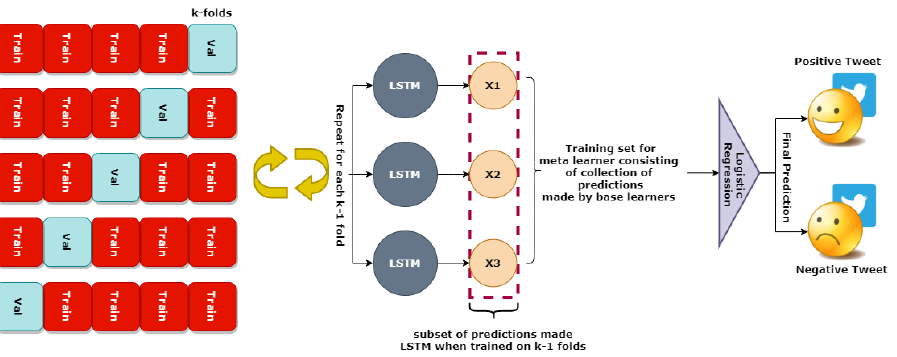
Figure 1. Architecture of the proposed LR-LSTM